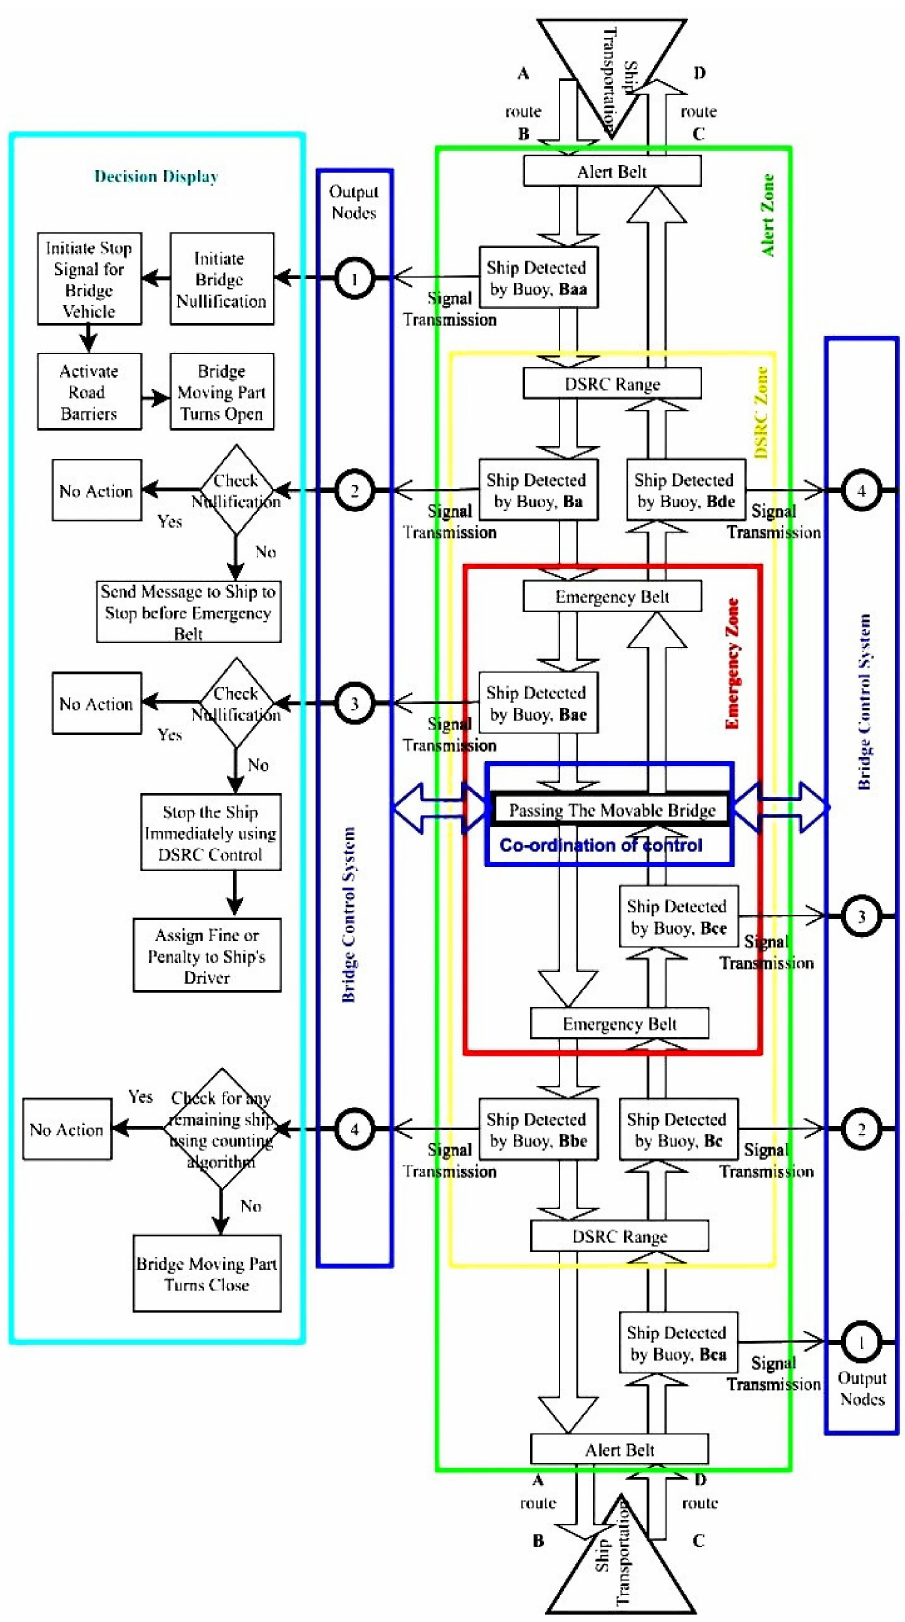
Figure 6. Flowchart for the control system of movable bridge maritime management and collision